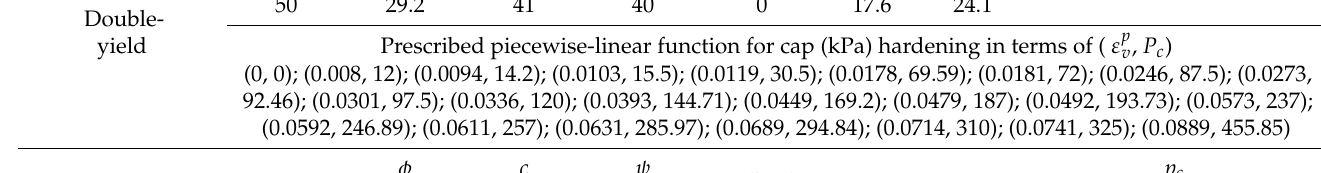
Prescribed piecewise-linear function for cap (kPa) hardening in terms of ( ε p v , P c